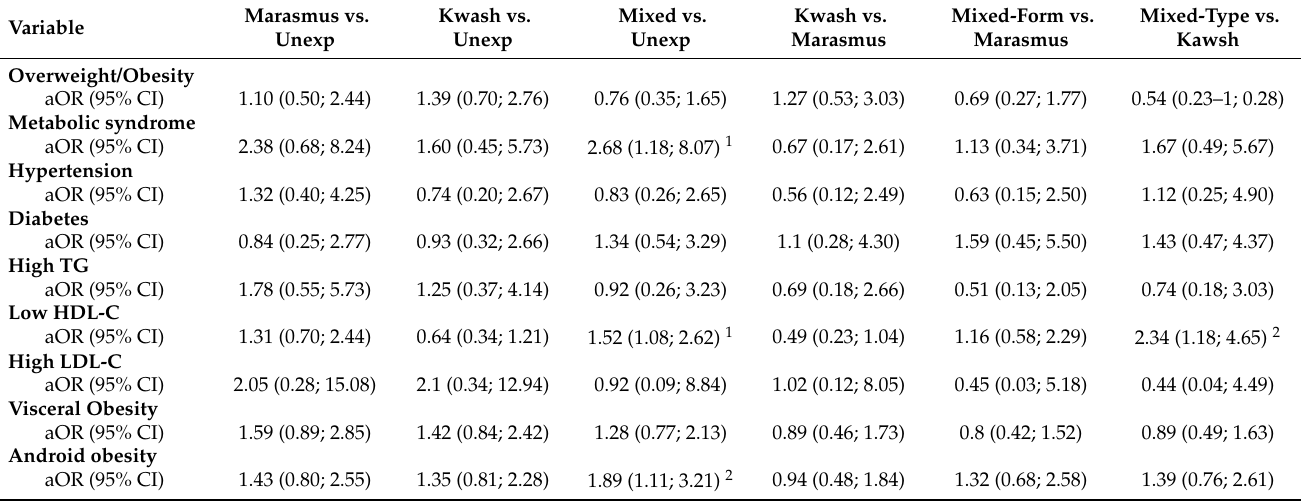
Table 3. Adjusted Odds Ratio of developing NCDs or their CVRFs (95% CIs) in SAM-exposed compared with